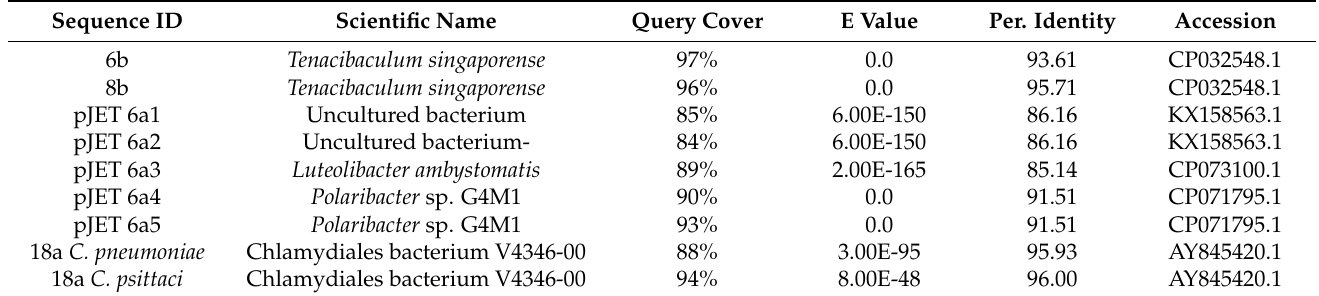
Table 2. Blast analysis results. Top hit from unfiltered blastn suite (NCBI BLAST ® ) for each sequence included in the Supplementary Materials Sequences